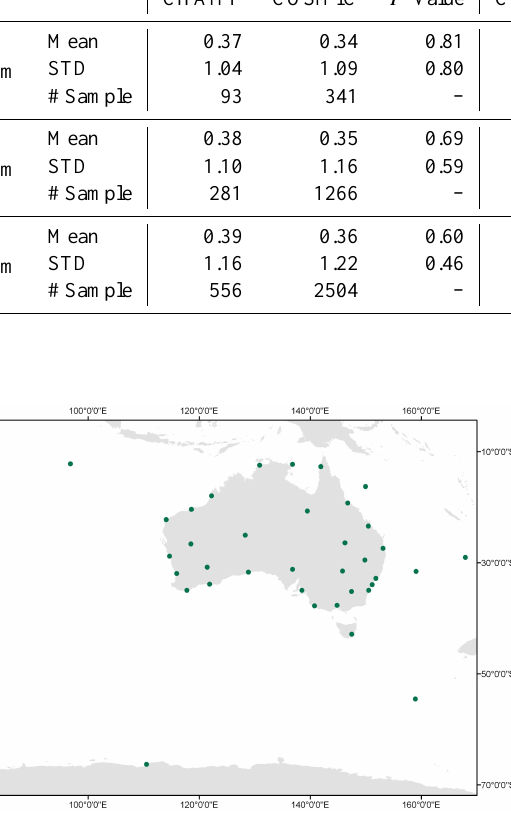
Fig. 1. Locations (dots on the map) of the 38 Australian radiosonde stations (Australian Bureau of Meteorology,